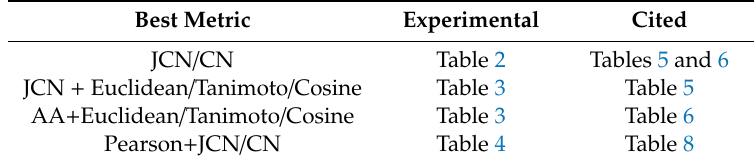
Table 7. The best proposed metrics as proposed by experiment in comparison to recent